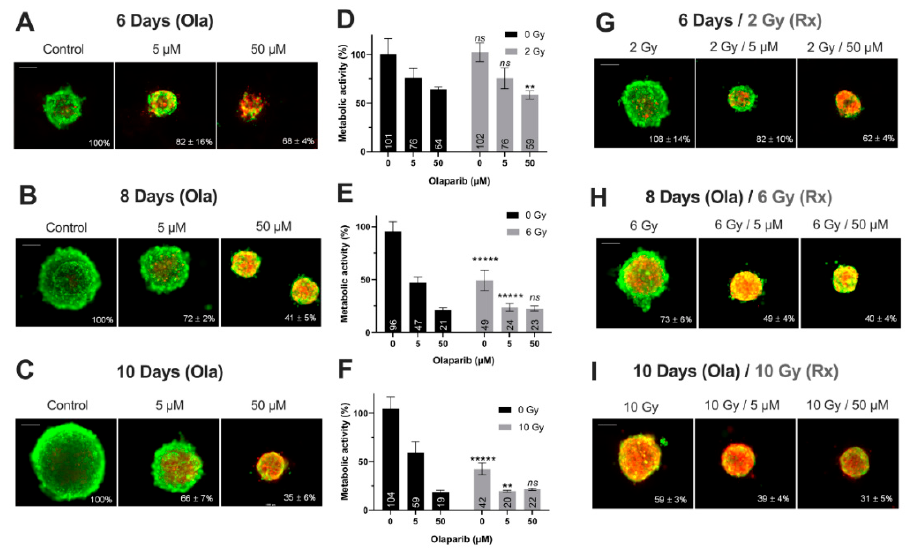
Figure 4. MDA-MB-231 spheroids live/dead profile ( A − C, G − I ) and metabolic activity ( D − F ) after a treatment with Olaparib (“Ola”, 5 and 5 µM) for 6, 8 and 10 days with or without fractioned irradiation (“Rx”). ( A − C,G − I ) Spheroid viability/mortality profile and spheroid normalized size after a treatment with Olaparib and/or fractioned irradiation for 6 days ( A , G ), 8 days ( B , H ) and 10 days ( C , I ): Images were taken with Cytation3MV where green markings correspond to calcein-AM penetration (viable cells) and red markings correspond to ethidium homodimer-1 cell penetration (dead cells). The percentage of spheroid size was normalized by the size of spheroid controls. Scale bar = 200 µm. ( D − F ) MDA-MB-231 cell metabolic activity in spheroids with resazurin test after 6 ( D ), 8 ( E ) and 10 days of treatment ( F ). Corrected fluorescence intensity of resorufin (ex/em λ 576/ λ 584 nm) was measured after 15 h incubation with 60 µM resazurin. The fluorescence intensity of treated spheroids ( n > 15) was normalized by the fluorescence intensity of each associated 0.1% DMSO control spheroids. Results are expressed as mean metabolic activity (%) of each treatment conditions with their standard errors. A student t -test was performed for the statistical comparison of all treatment conditions and the p -value is represented in the graphs as ns = non-significant, ** p < 0.01 and ***** p < 0.00001.